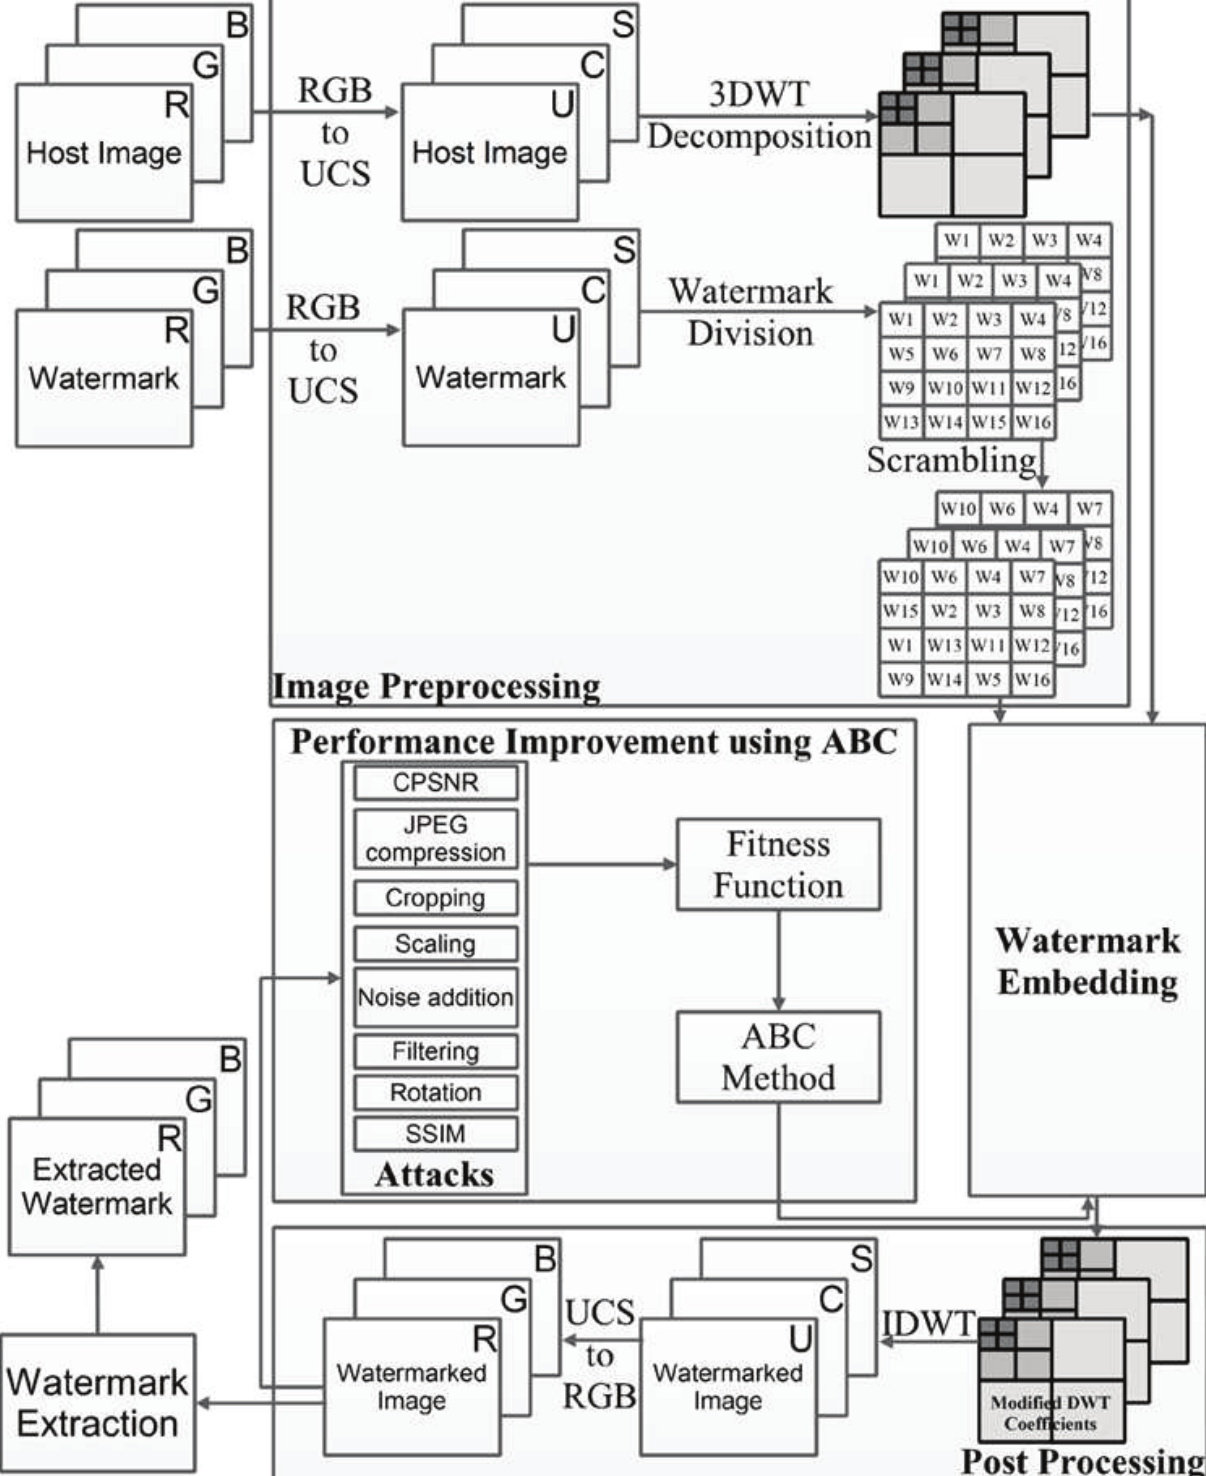
Figure 2: Structural design of proposed